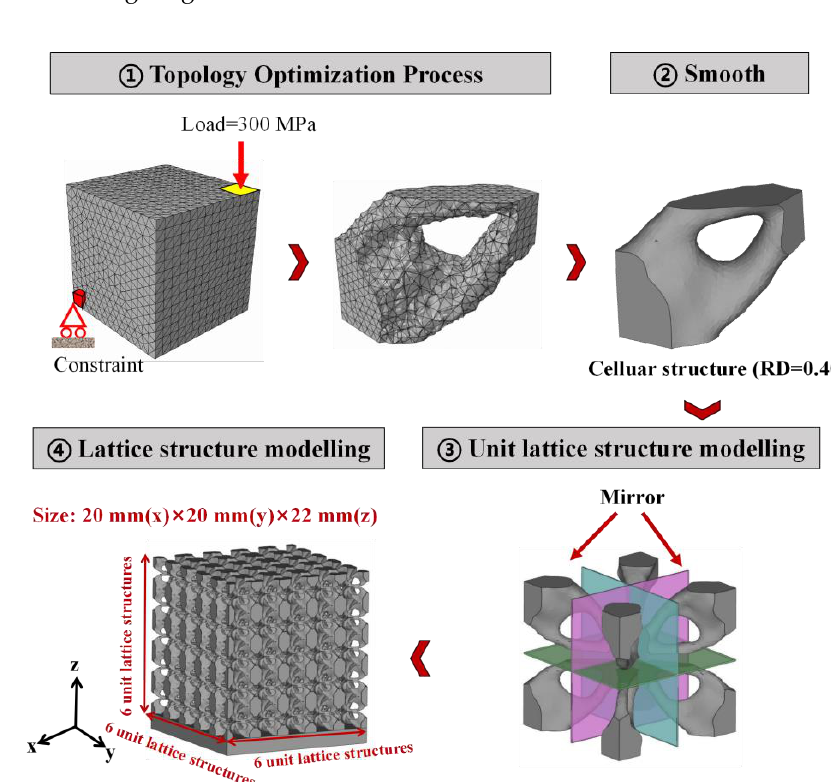
Figure 1. Detailed topology optimization process of lattice structures.